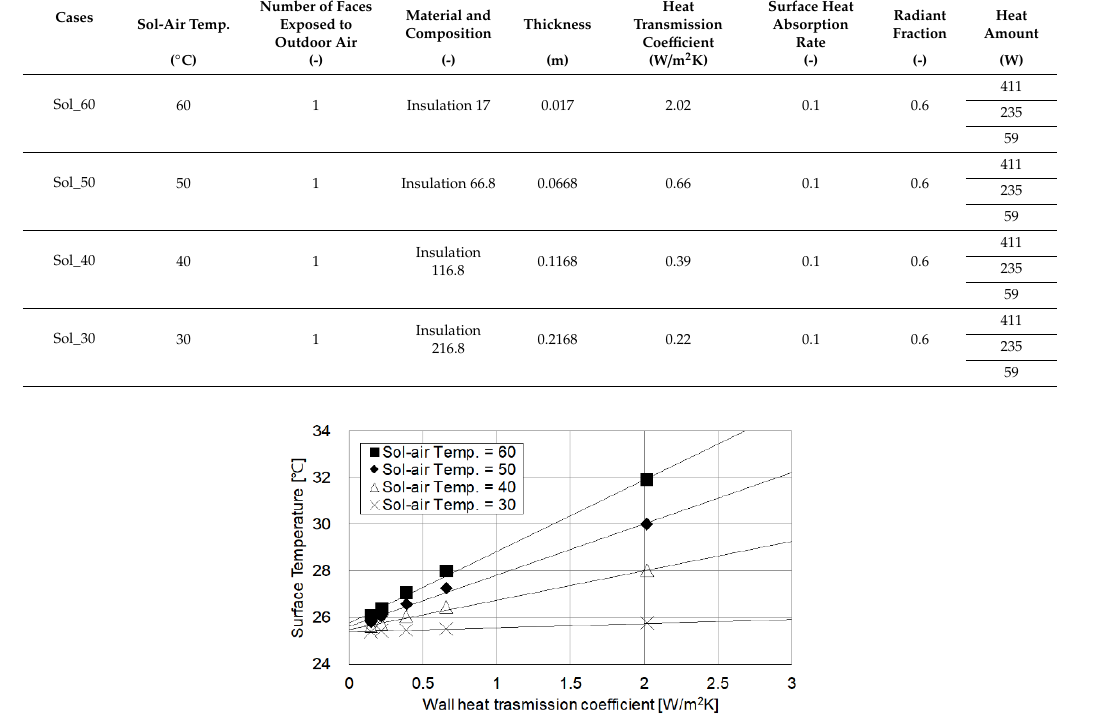
Figure 11. Wall heat transmission coe ffi cient and surface temperature for sol-air temperature.